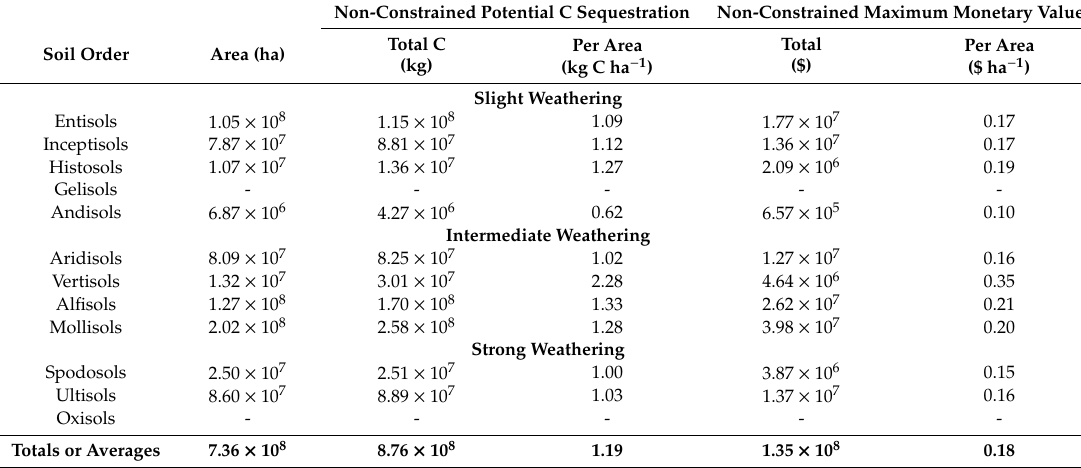
Table 4. Average annual total and area-normalized non-constrained potential soil inorganic carbon (SIC) sequestration within the contiguous United States (U.S.) from combined atmospheric Ca 2 + and Mg 2 + deposition (2000–2015) based on an avoided SC–CO 2 of $42 per metric ton of CO 2 [16]. Non-Constrained Potential C Sequestration